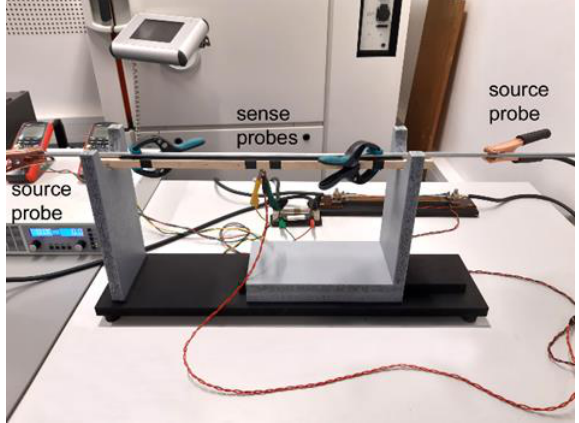
Figure 2. Experimental setup for electric measurements with depicted locations of sense and source probes.